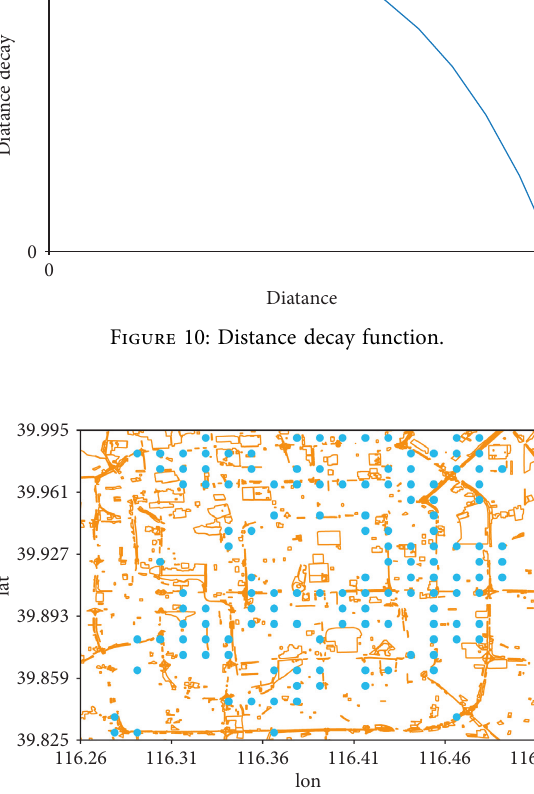
Figure 11: Spatial distribution of candidate stations.